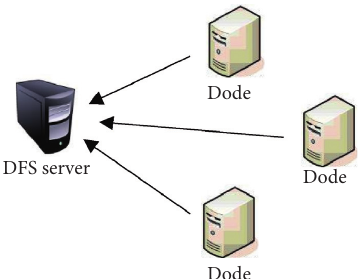
Figure 1: Parallel computing model based on cloud